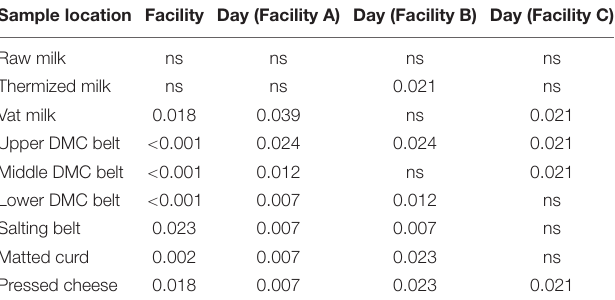
TABLE 1 | P -values from the Kruskal-Wallis test for differences in Shannon’s alpha diversity between facilities and between days within each